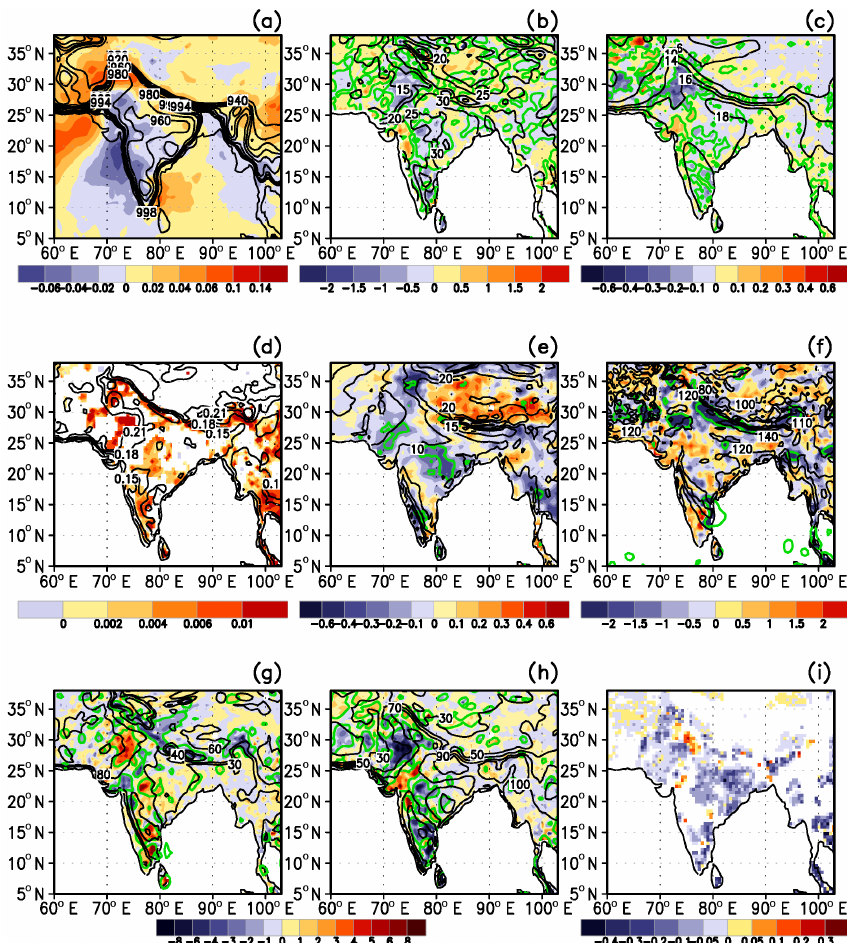
Figure 10. (a) Seasonal (JJAS)-averaged surface pressure in PLC experiment (in black contours) and its difference (PLC–HLC) in shaded color (in hPa; 1982–2008). Green contour shows differences significant at the 90% confidence level. (b) – (i) Show similar differences as in (a) but for surface soil moisture (0–10cm; in mm), 2m specific humidity (in gkg − 1 ), surface albedo (unitless), total cloud cover (in %), surface net radiation (in Wm − 2 ), surface sensible heat flux (in Wm − 2 ), surface latent heat flux (in Wm − 2 ). (i) Shows only the difference (PLC– HLC) in sum of transpiration and evaporation of canopy-intercepted water (in mmday − 1 ). In (d) and (i) , only the differences significant at the 90% confidence level are